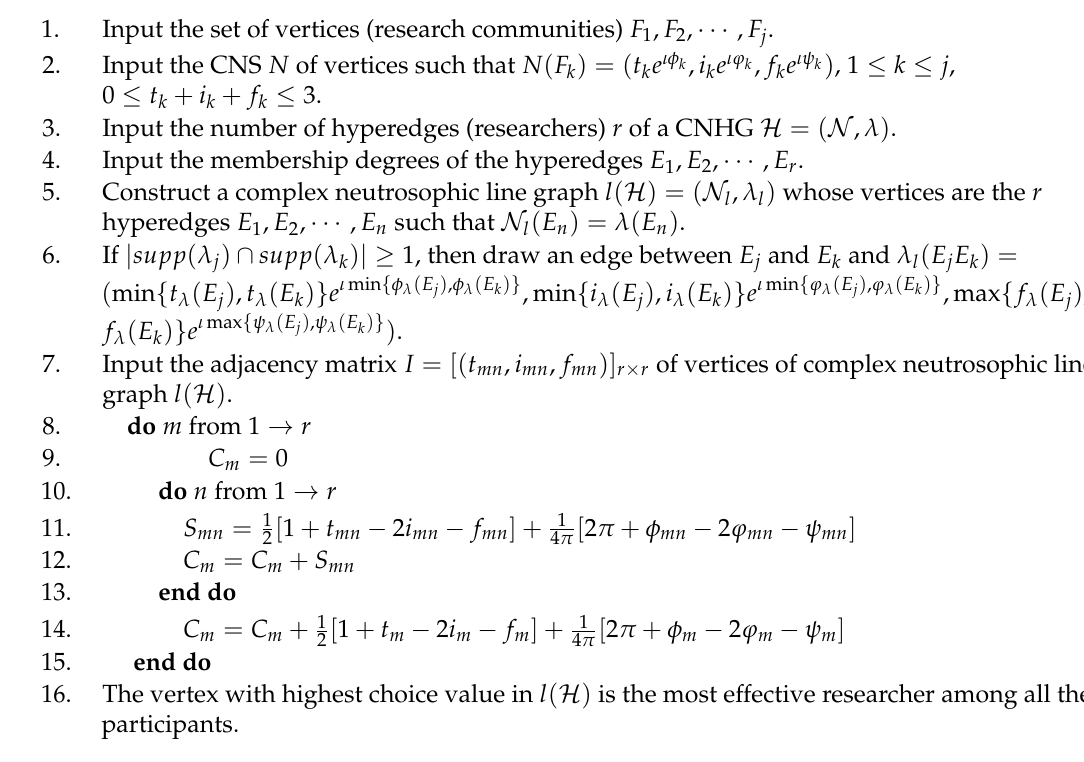
Algorithm 1: Selection of a systematic member from intersecting research